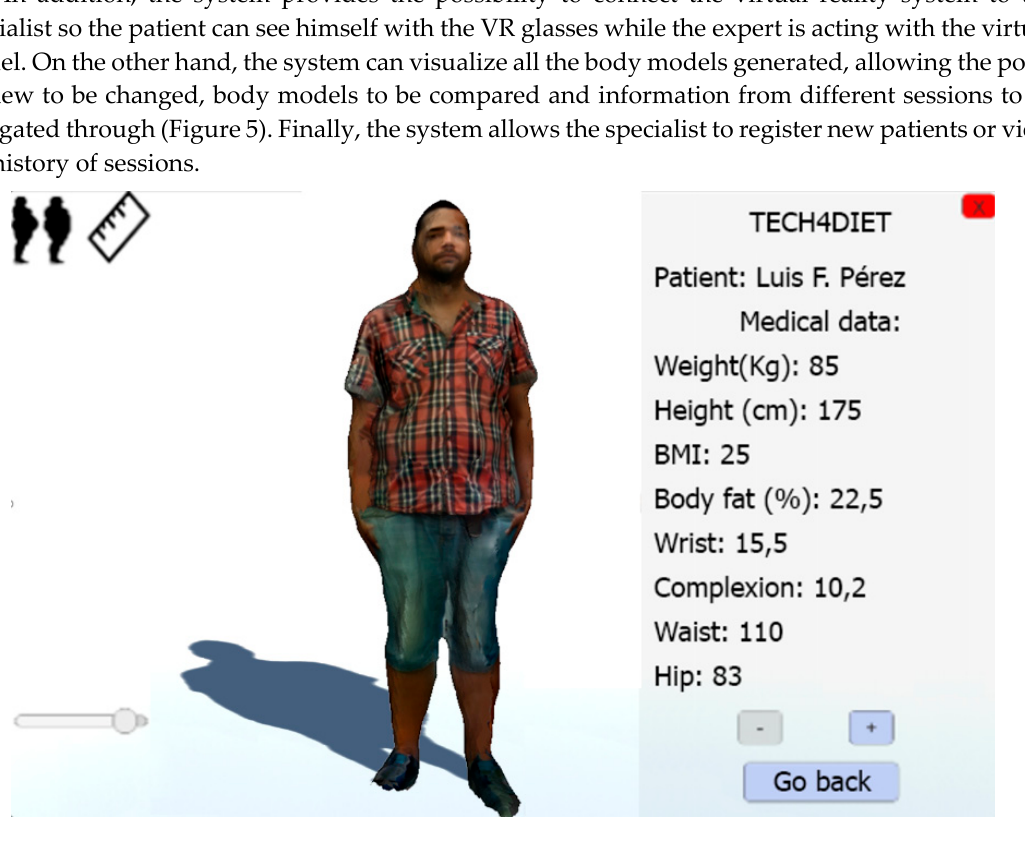
Figure 5. 4D visualization of a sequence of 3D